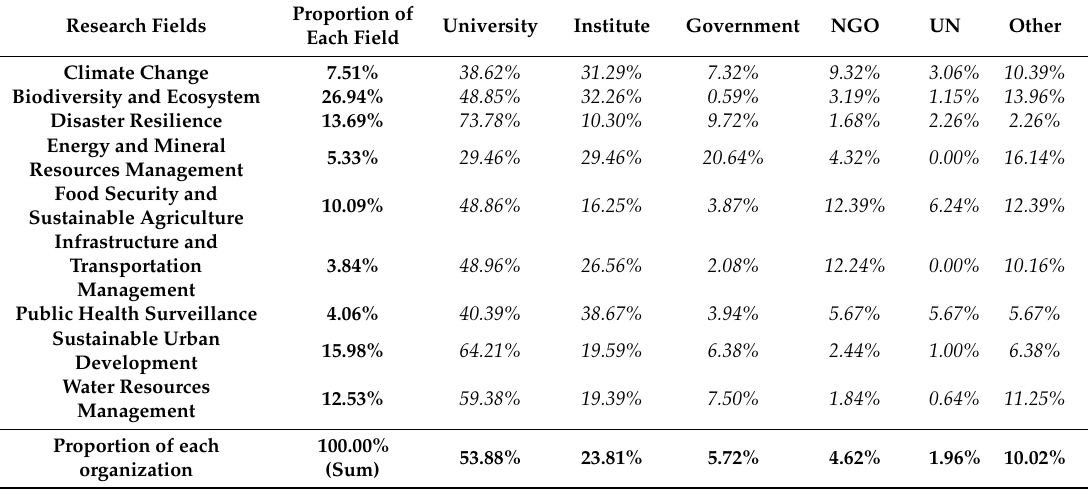
Table 3. Major application fields of